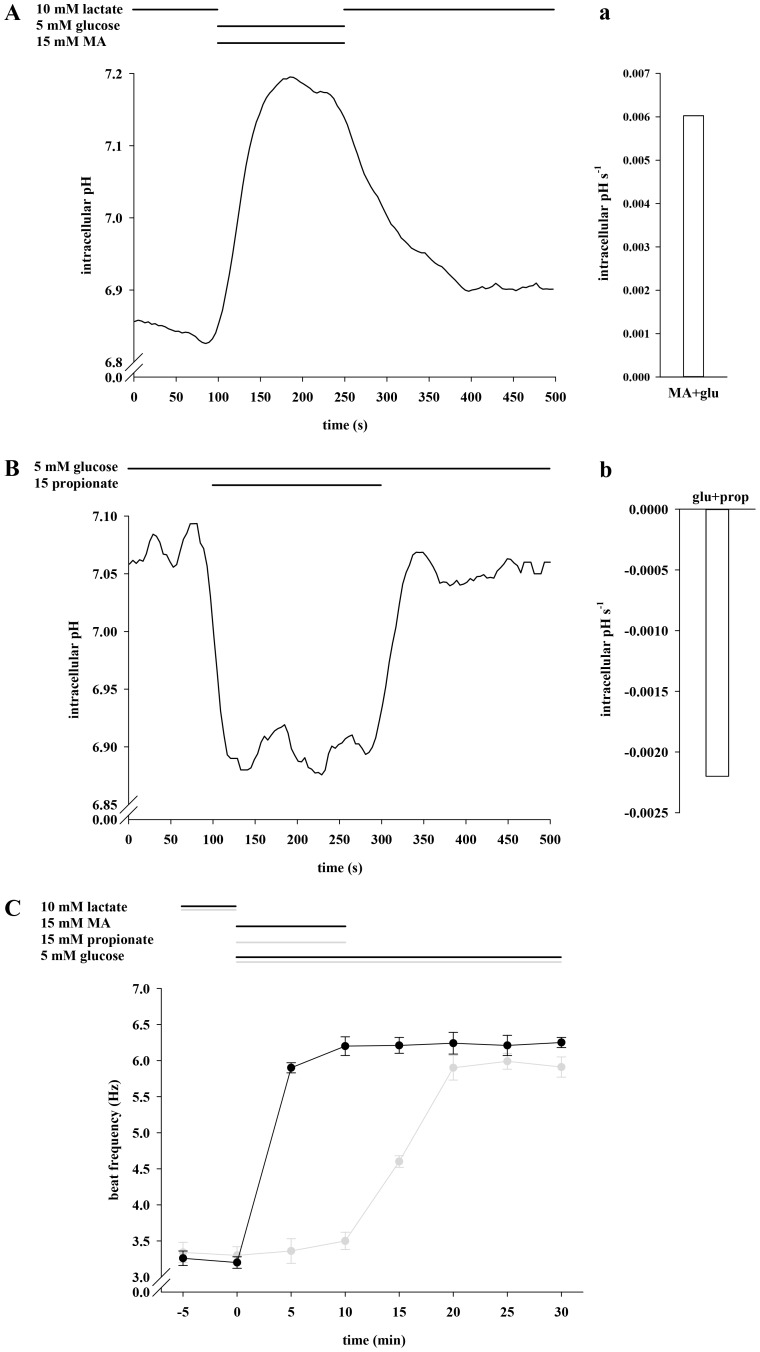
Methylamine (MA) hastens and propionic acid inhibits the enhancing effect of glucose on sperm beat frequency.
A, Sperm were exposed for 100 s to 10 mM lactate before being stimulated for 150 s with 5 mM glucose and 15 mM MA. Subsequently, cells were allowed to recover for 200 s in lactate-containing buffer. B, Cells were treated for 500 s with 5 mM glucose of which propionate was additionally present during 200 s as indicated. The plots of A and B show mean values of 25–33 cells of 3 animals. Mean slopes (in a and b) were analyzed as described in the previous figure legend. C, After primary perifusion with 10 mM lactate, sperm were perifused for 30 min with buffer HS containing 5 mM glucose of which 15 mM MA (black plot) or 15 mM propionate (gray plot) were concurrently present first 10 min (t  = 0 min to t = 10 min). Significant changes were analyzed relating to t  = 0 min and apparent at t ≥5 min (co-application of MA) and at t ≥15 min (after removal propionate) with ***p<0.001. Shown are mean values±s.e. of 40 cells of 3 animals.